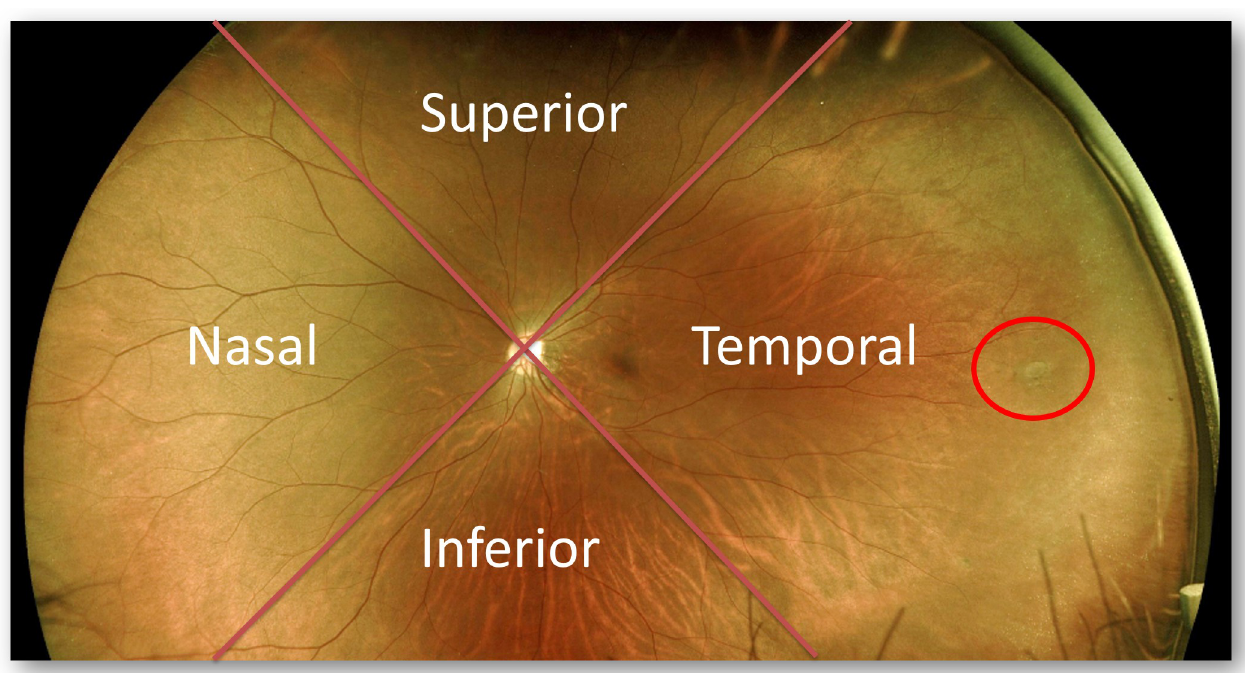
Fig 2. Four fundus quadrants and identification of retinal breaks. We divided the fundus into the superior, inferior, temporal, and nasal quadrants, with the optic disc at the center. We then counted the retinal breaks (red circle) of the total fundus and the four quadrants.